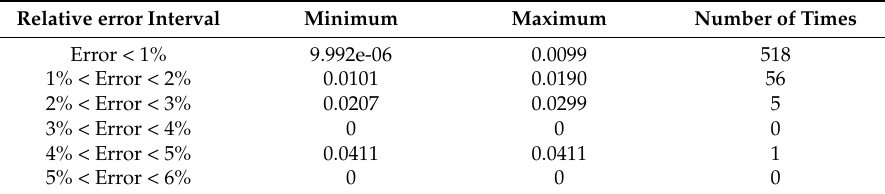
Figure 11. Relative error. Table 4. Relative error statistics.